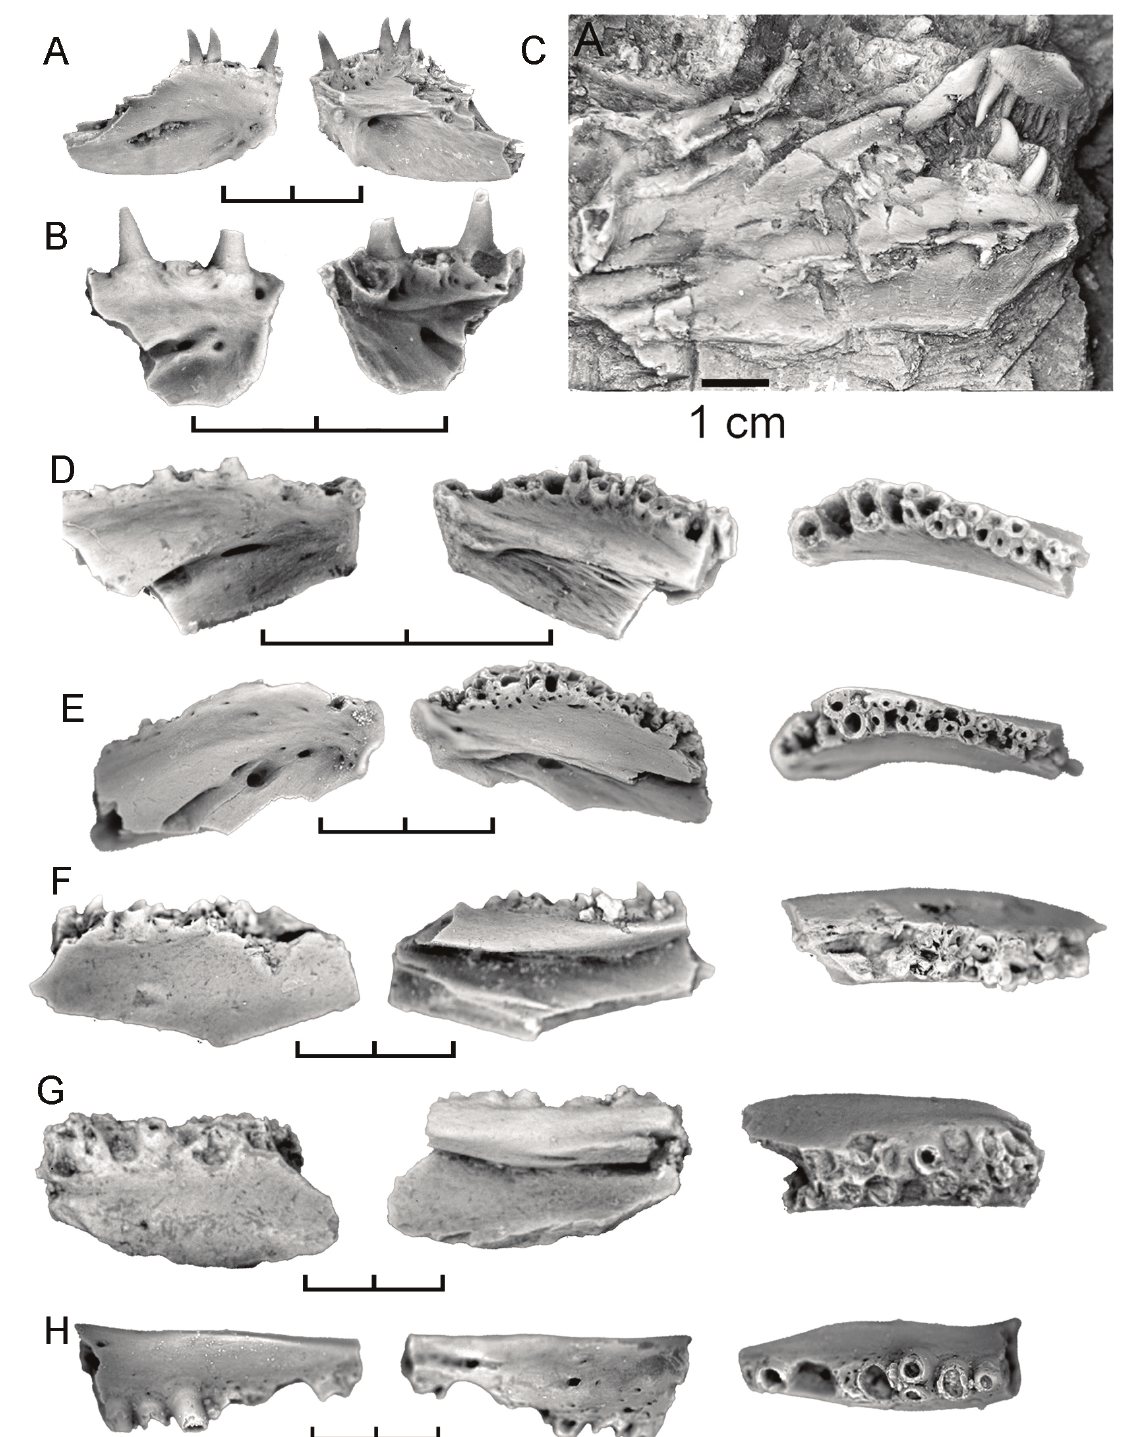
Figure 12. Dentaries and maxillae of Wilsonichthys from the Milk River Formation compared with specimens from late Maastrichtian of Alberta, and Montana and the Turonian of Utah. A) dentary referred to Wilsonicththys sp., from the Hell Creek Formation, UCMP 198883/V99369. B) dentary referred to Wilsonichthys sp., from the Scollard Formation, TMP 2009.13.62. C) close up photo of the dentary, maxilla, and premaxilla of the holotype of Wilsonichthys aridinsulensis , TMP 2012.020.1493, Scollard Formation. D) dentary referred to Wilsonichthys sp., from the late Turonian Smoky Hollow Member of the Straight Cliffs Formation of Utah, from locality MNA995. E) dentary referred to Wilsonichthys sp., from late Campanian Dinosaur Park Formation, TMP 95.180.61. F – G) dentary frag - ments from the Milk River Formation referred to Wilsonichthys sp. F, UALVP 49030; G, UALVP 34770. H) maxilla from the Milk River Formation referred to Wilsonichthys sp., UALVP 49029. A from Brinkman et al. (2014: fig. 12A). Scale bar equals 2